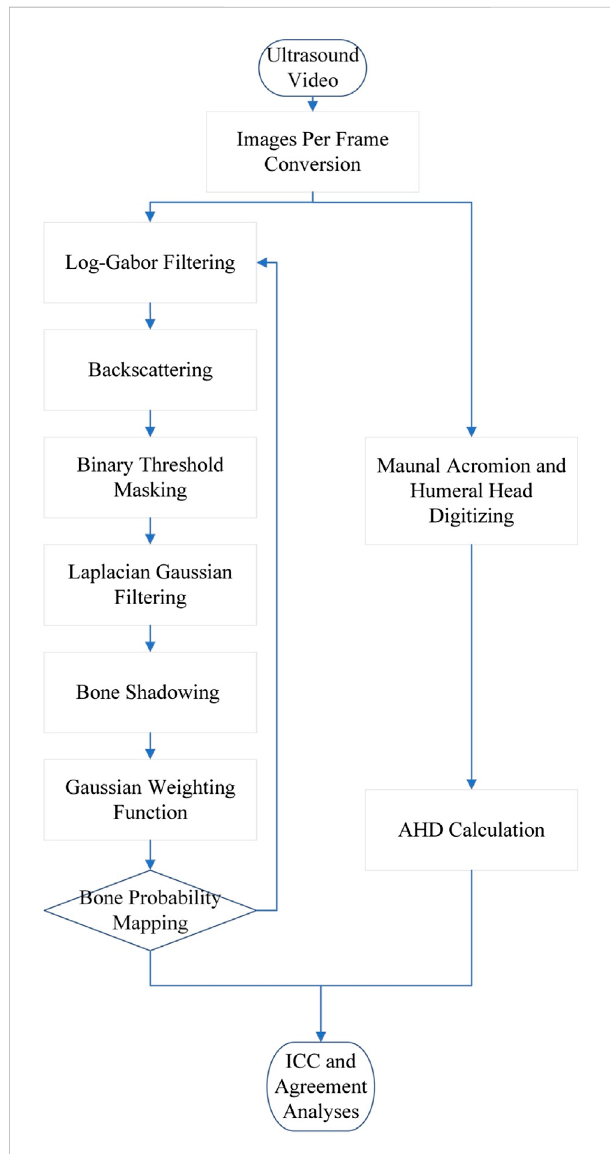
FIGURE 1 Flowchart of the proposed computer-aided quantitative ultrasound algorithm (CAQUSA) for processing an ultrasound video clip to quantify the acromiohumeral stance in wheelchair users with spinal cord